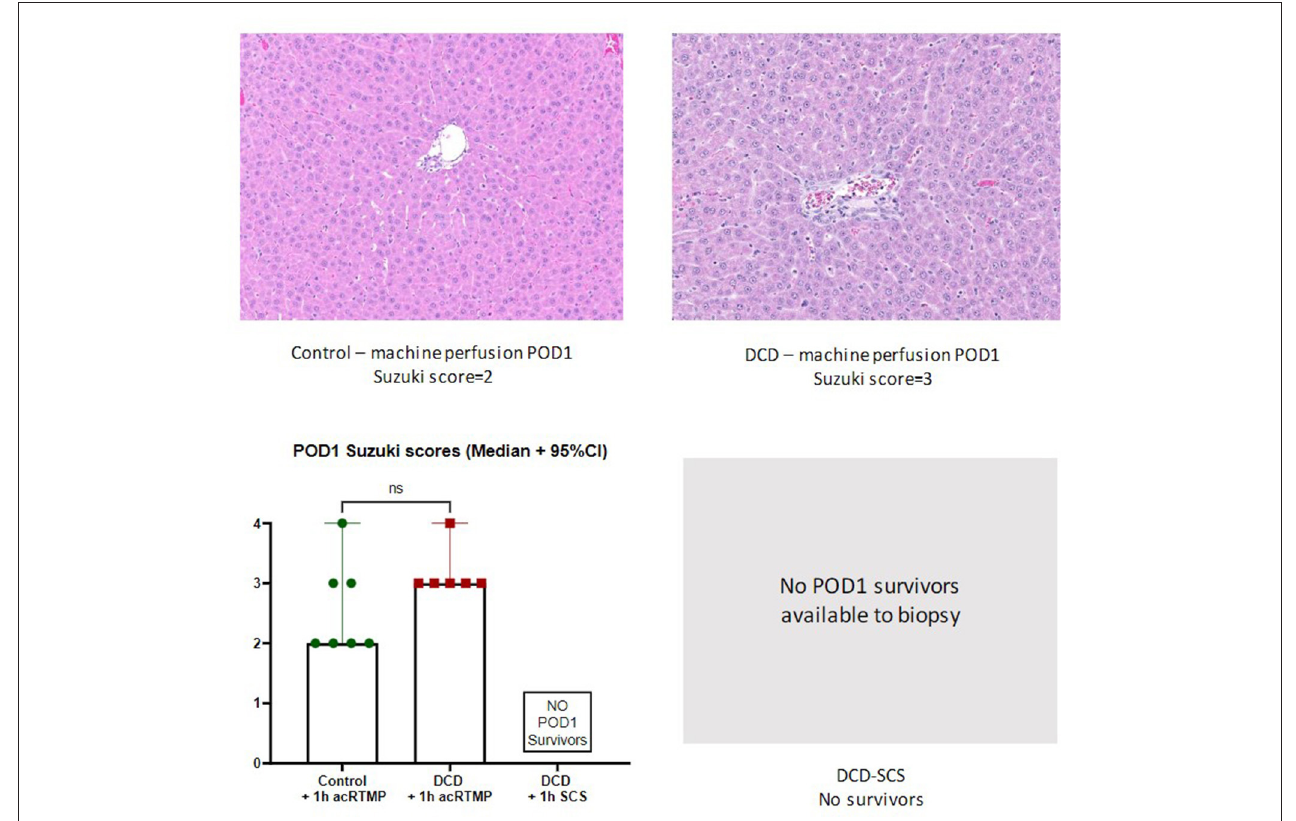
FIGURE 9 | Graft histologic injury by Suzuki score at study